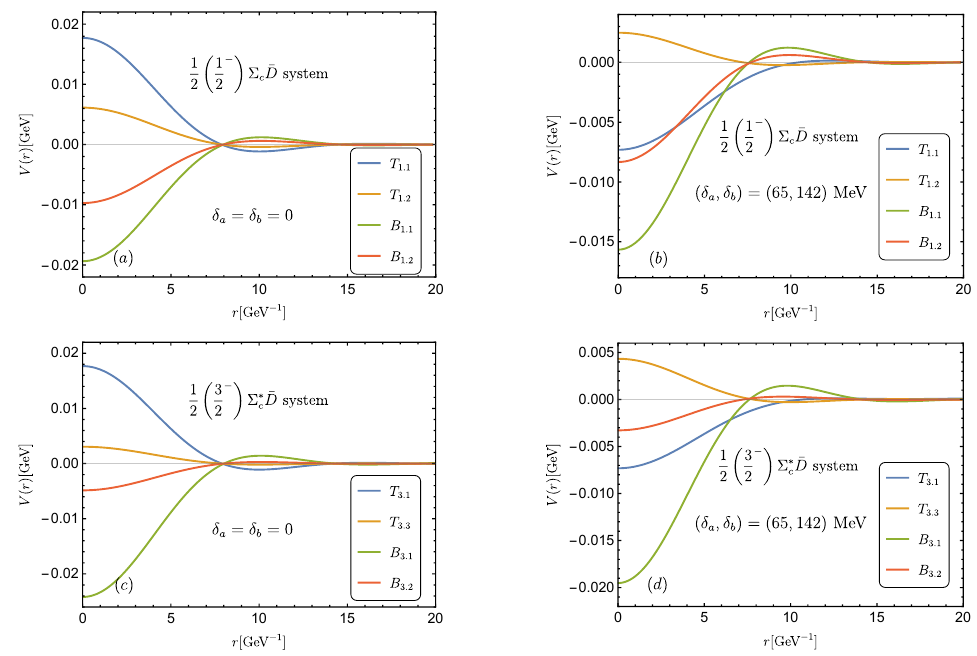
Figure 15 . The behaviors of the two-pion-exchange potentials of each mass splitting related 2PI diagrams for the [(cid:6) c (cid:22) D ] 1